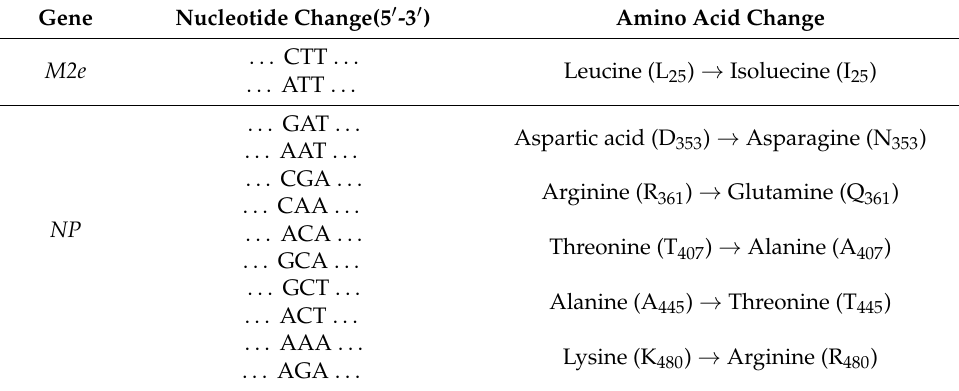
Table 3. Nucleotide and amino acid changes found in the M2e-NP fusion gene.